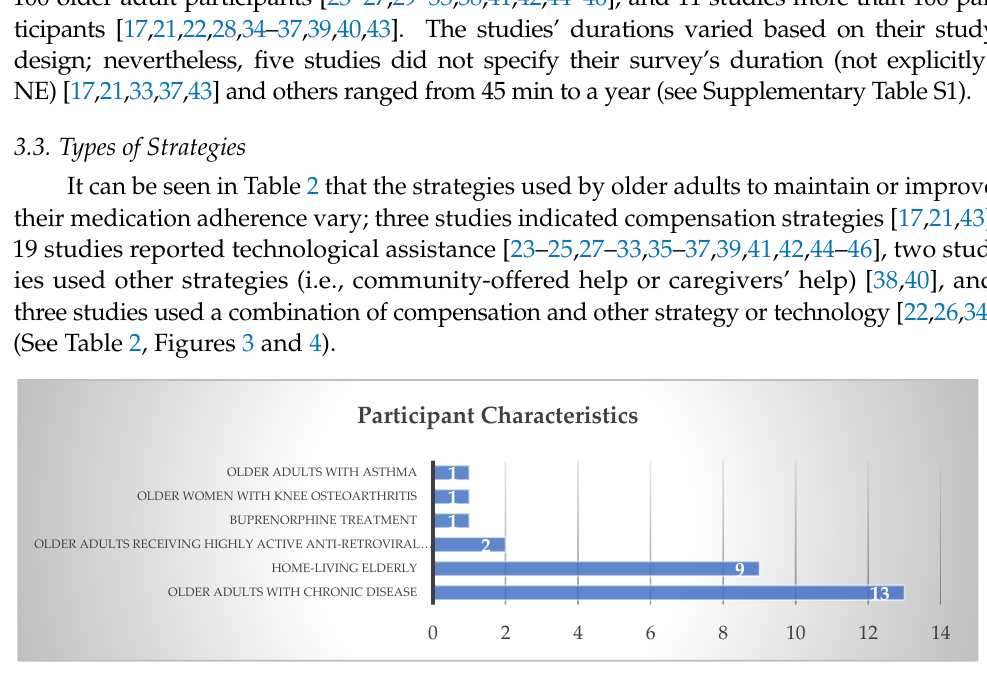
Figure 3. Participant Characteristics.